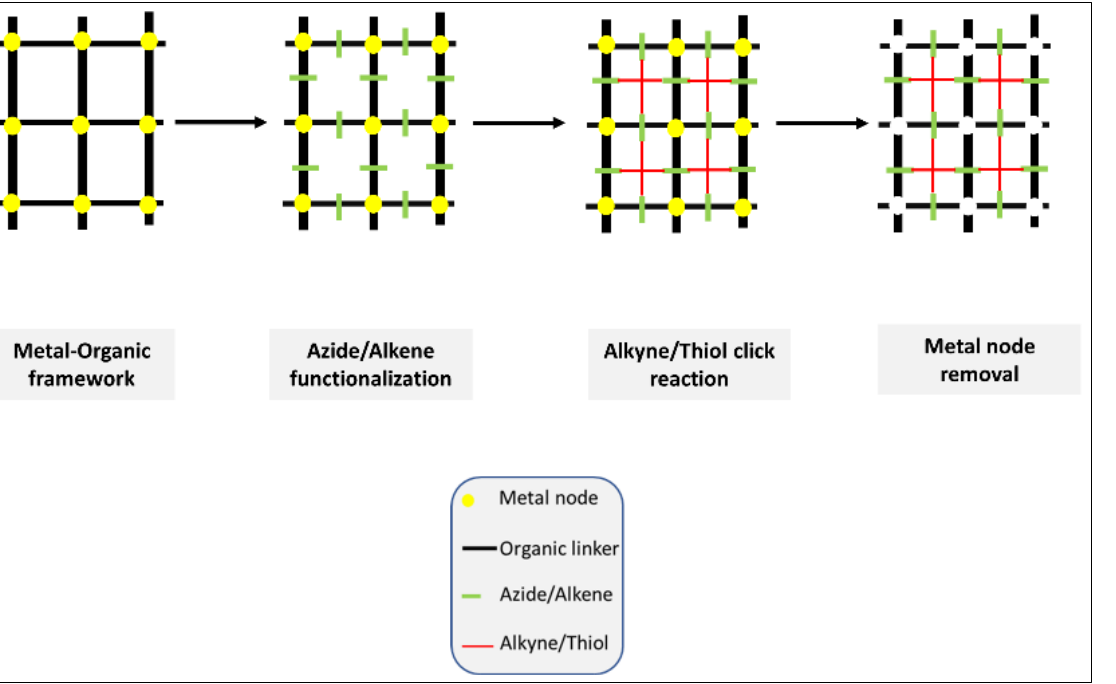
Figure 5. Hierarchical structures from MOF (Metal/covalent Organic frame) using click chemistry.